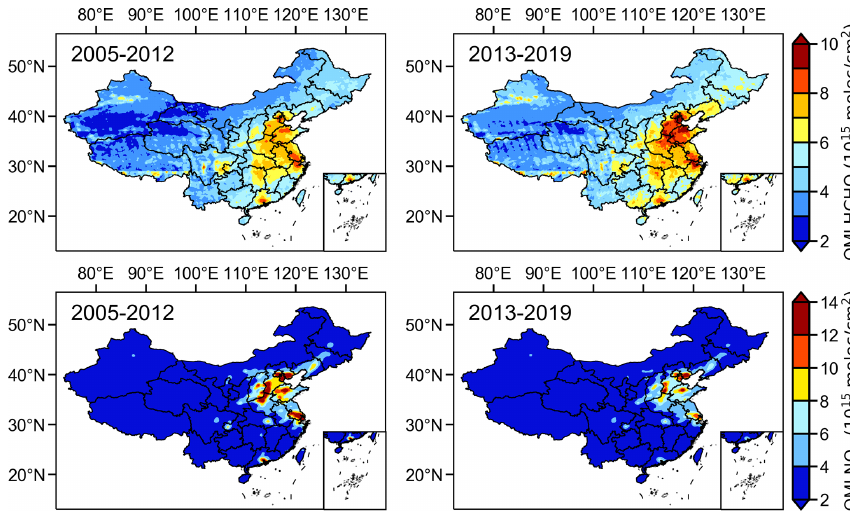
Figure 4. May-to-September averaged HCHO and NO 2 across China during the period of 2005–2012 and 2013–2019.